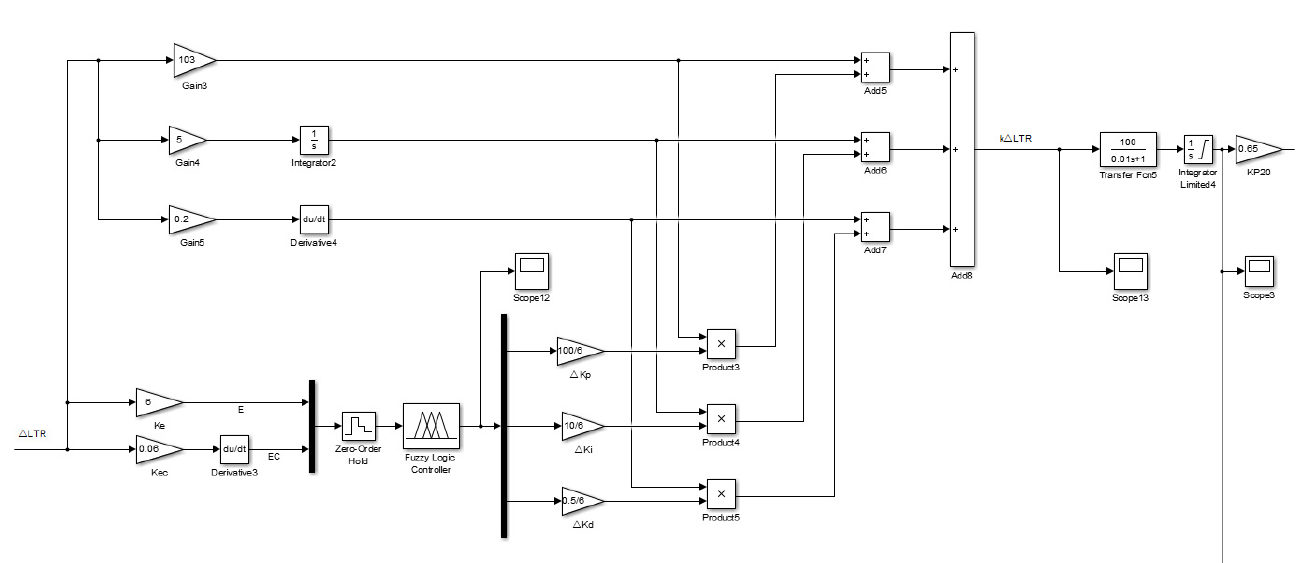
Figure 10. Fuzzy self-adjusting PID controller.